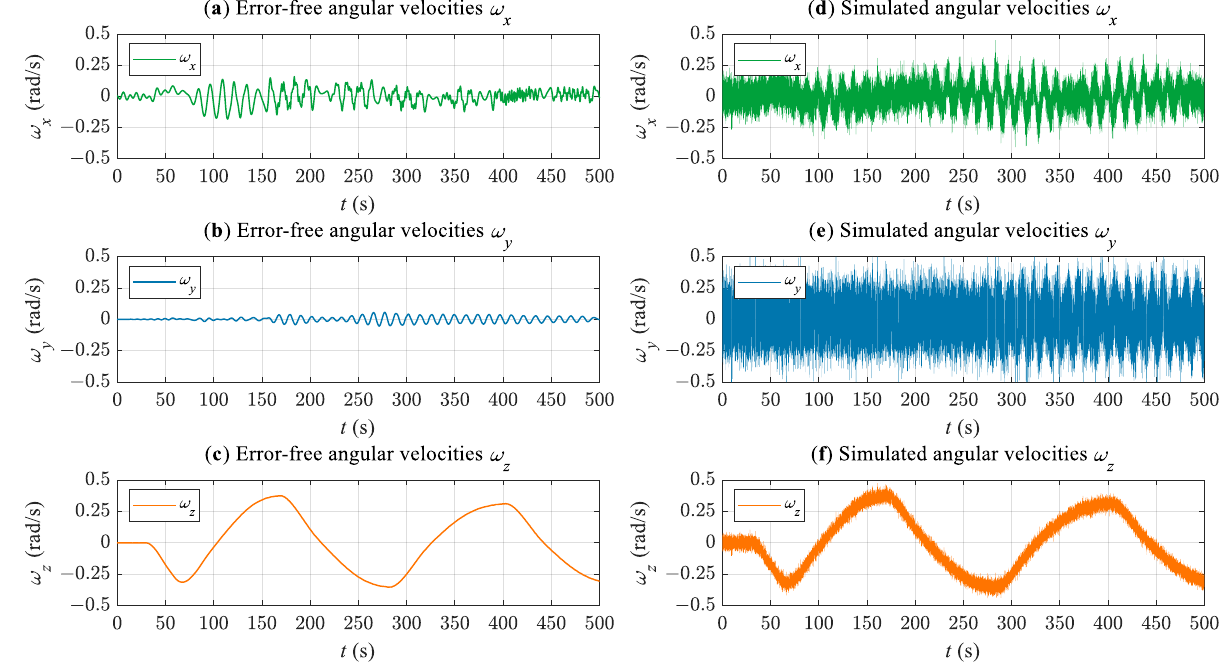
Figure 9. Error-free and simulated angular velocities. ( a ) error-free angular velocities of x direction; ( b ) error-free angular velocities of y direction; ( c ) error-free angular velocities of z direction; ( d ) simulated angular velocities of x direction; ( e ) simulated angular velocities of y direction; ( f ) simulated angular velocities of z direction.